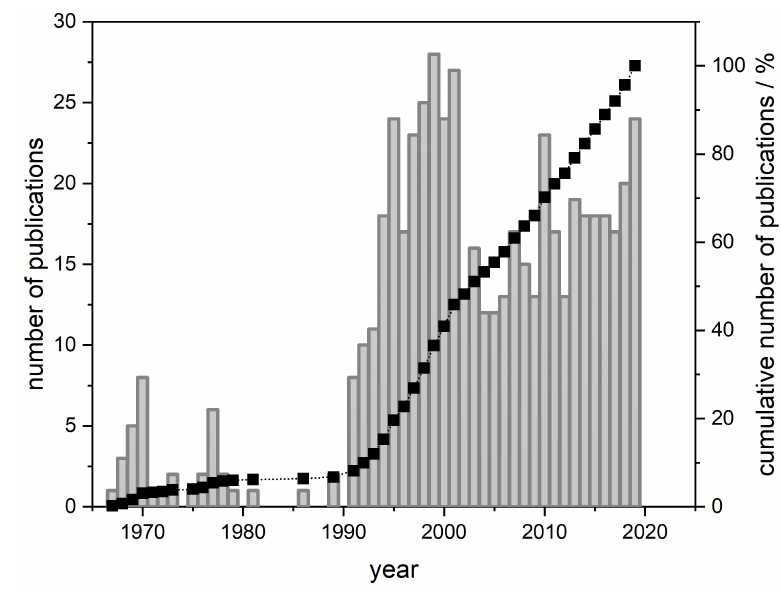
Figure 1. Number of publications related to the saponin β -aescin in the years 1967 to 2019. The data is obtained from a search in the ”The Web of Science Core Collection” database under the keyword